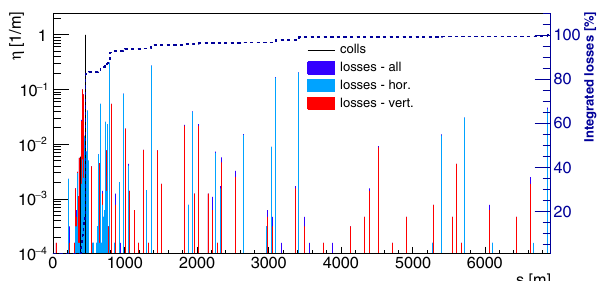
FIG. 10. Local cleaning inefficiency in case of a hierarchy breakage. Aperture model: after LS2.